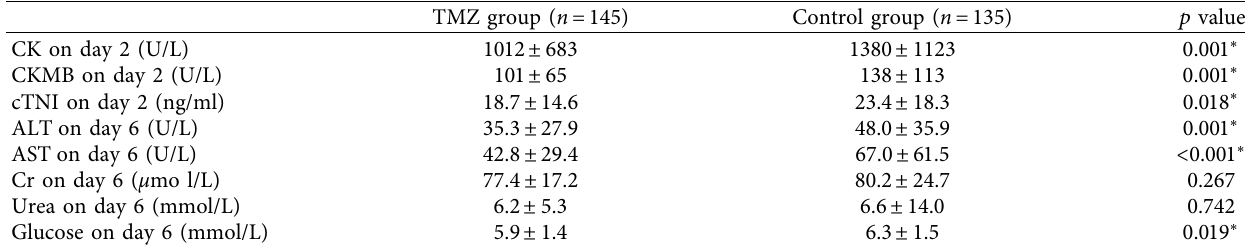
Table 6: Repeated laboratory data collected in the hospital.